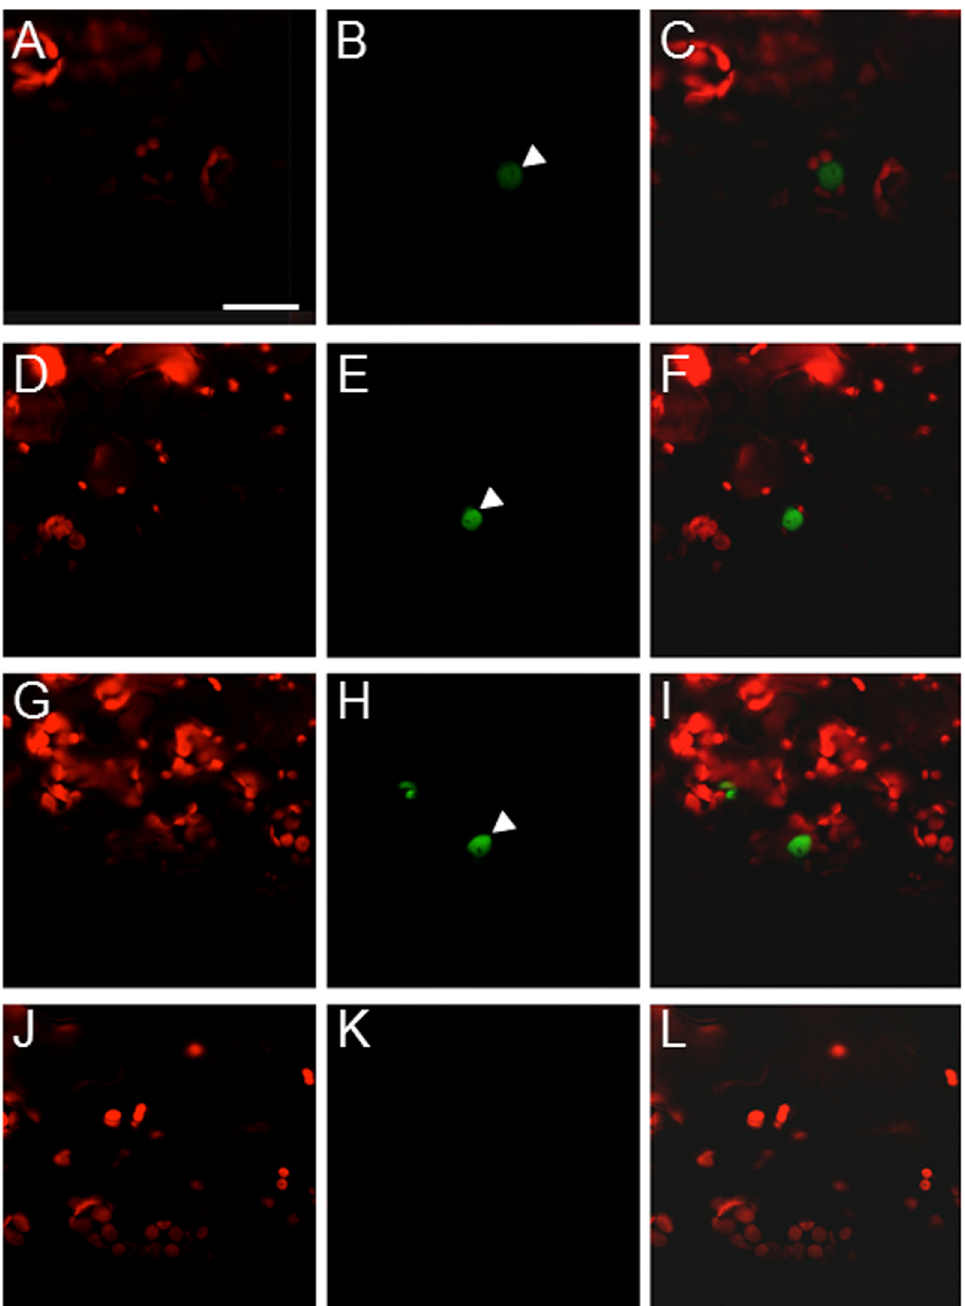
Fig 4. VirF and 6b interact with the VFP3 homolog, VFP5, in planta. (A-C) BiFC assay for the cYFP-VirF interaction with nYFP-VFP5. (D-F) BiFC assay for the cYFP-6b interaction with nYFP-VFP3. (G-I) BiFC assay for the cYFP-6b interaction with nYFP-VFP5. (J-L) BiFC assay for the cYFP-6b interaction with nYFP-At3g58630. Constructs encoding the tested proteins were coexpressed in microbombarded N . benthamiana leaves. (A, D, G, J) Plastid autofluorescence. (B, E, H, K) YFP signal. (C, F, I, L) Merged plastid autofluorescence and YFP signals. Location of the cell nucleus is indicated by a white arrowhead. All images are projections of single confocal sections. Scale bars, 20 μ m.